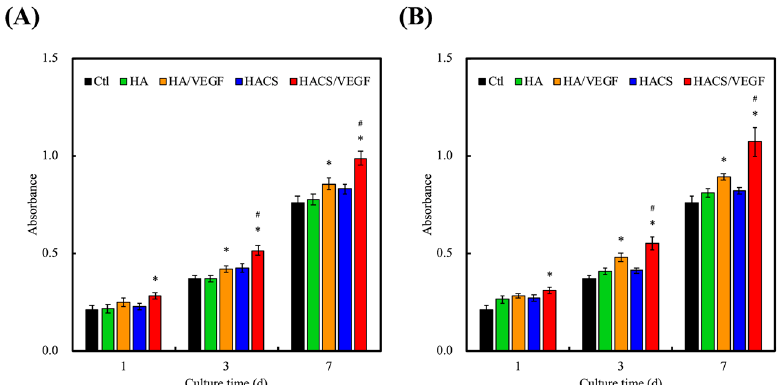
Figure 5. The proliferation of ( A ) human mesenchymal stem cells (hMSCs) and ( B ) human umbilical vein endothelial cells (HUVECs) cultured on different 3D-printed scaffolds. “*” indicates a significant difference ( p < 0.05) when compared to the scaffold without VEGF. “#” indicates a significant difference ( p < 0.05) when compared to HA/VEGF.